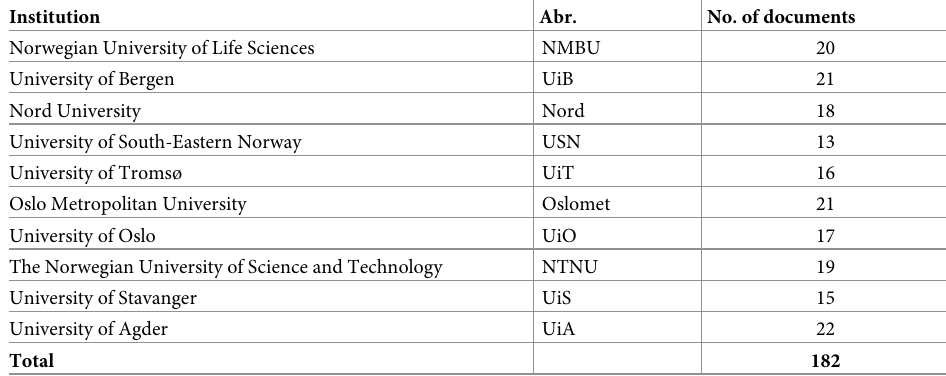
Table 1. Overview of institutions, abbreviations and number of